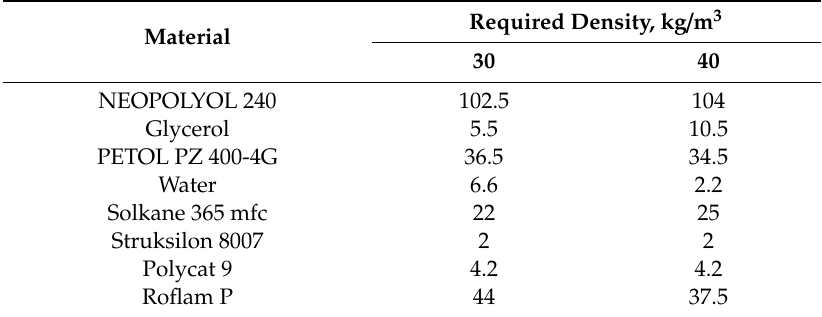
Table 1. Theoretically correct polyurethane foam compositions for two types of densities. Material